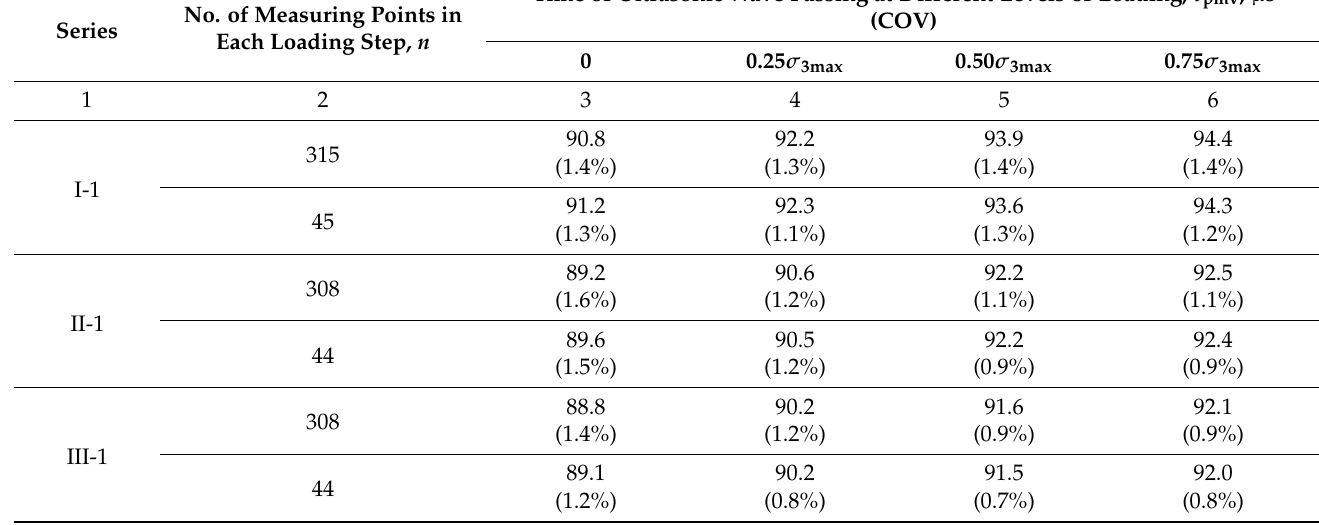
Table 5. Results from measuring propagation of ultrasonic